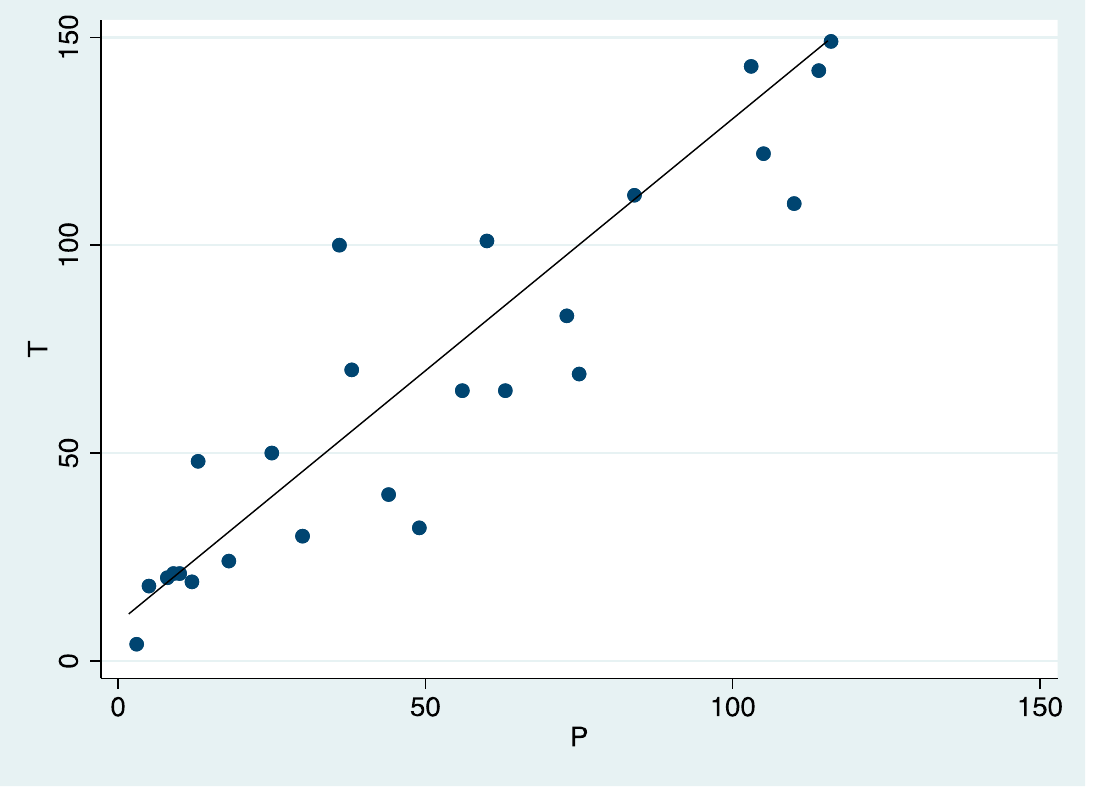
Table 6. Rankings before the tournament, predicted by the ranking of the preceding preliminaries (regression r T = B × r P + C).